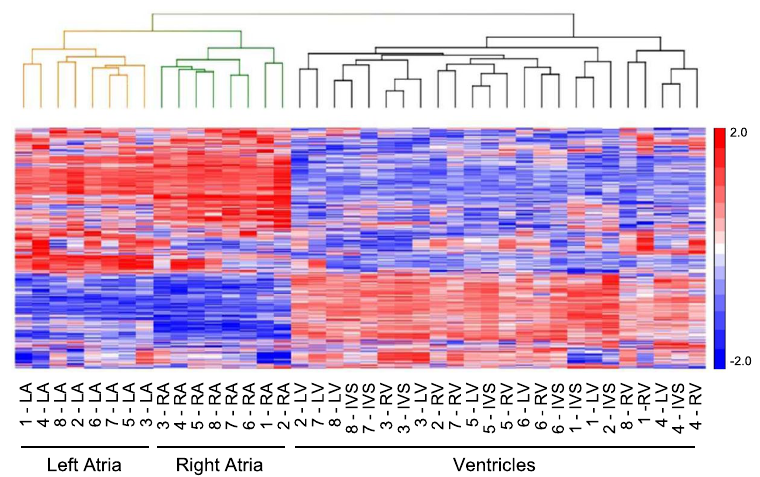
Figure 2. Differentially expressed mRNAs distinguish non-failing human LA and RA. Unsupervised hierarchical clustering and heat map of the expression profiles of the top 100 (greatest difference) differentially expressed cardiac mRNAs distinguish the LA (orange) from the RA (green) samples, as well as from the LV, RV and IVS (black) samples. Normalized read counts were standardized so that the row mean was zero and the standard deviation was 1. Data ranges for higher (red) and lower (blue) expressed mRNAs are